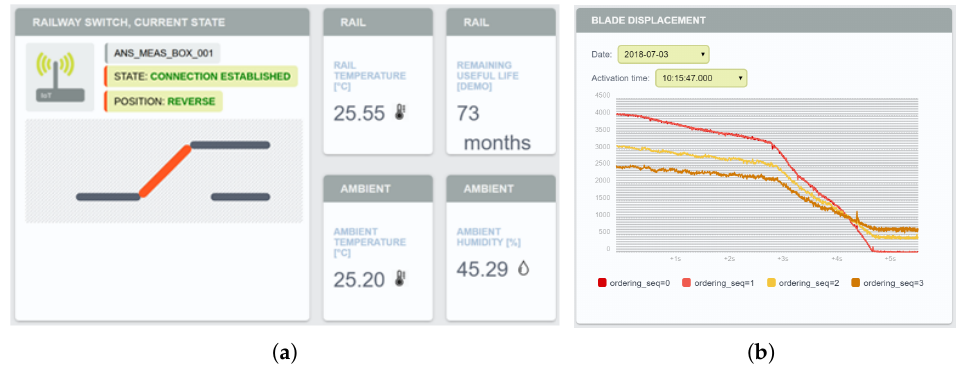
Figure 12. HMI part/widgets: ( a ) Main status information of the railway switch, ( b ) blade displacement monitoring of a railway switch.